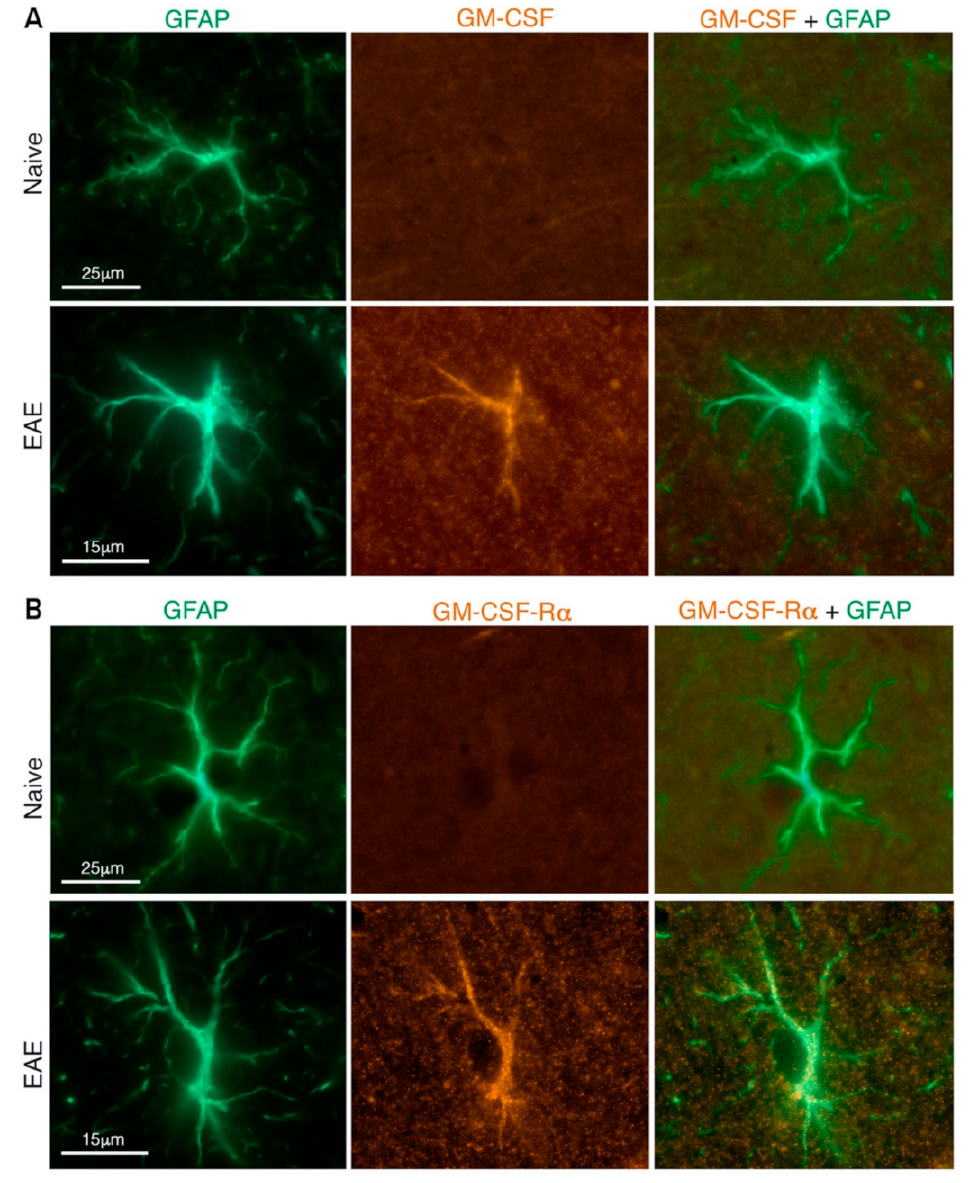
Figure 2. Astrocyte expression of GM-CSF and its receptor (subunit α ) GM-CSFR α . Representative immunohistochemical images from the somatosensory cortex (layer 4). ( A ) GM-CSF expression and ( B ) GM-CSFR α expression by GFAP expressing astrocytes in EAE-affected mice, but not in naïve mice. Reprinted with permission from Eilam et al. (2018). Copyright Year 2021, John Wiley and